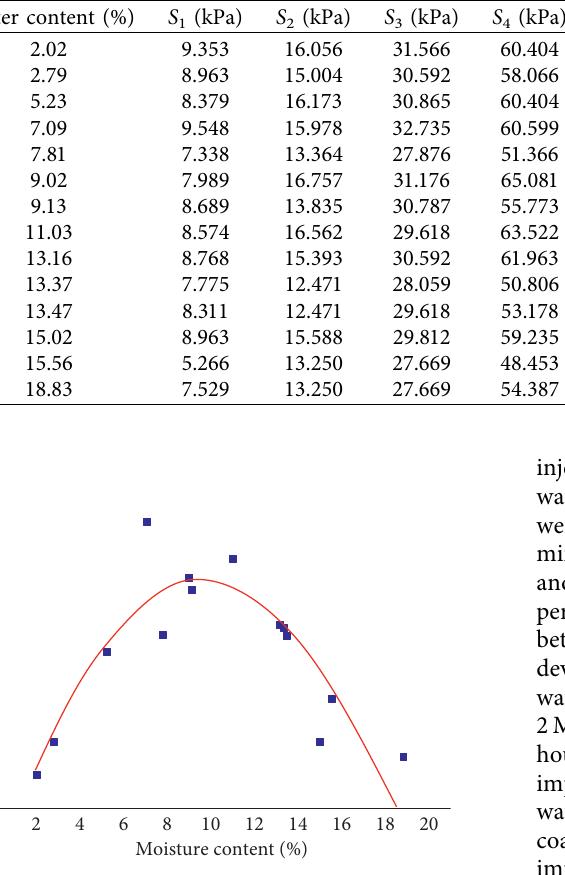
Figure 13: Variation trends of the cohesion with different water content levels.